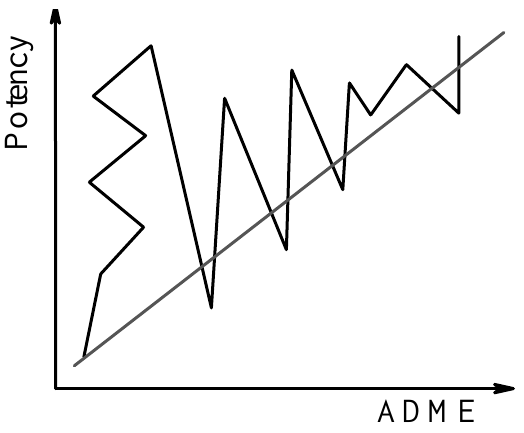
Figure 1. First scenario: Binding affinity (potency) is optimised first; ADME properties are optimised at a later